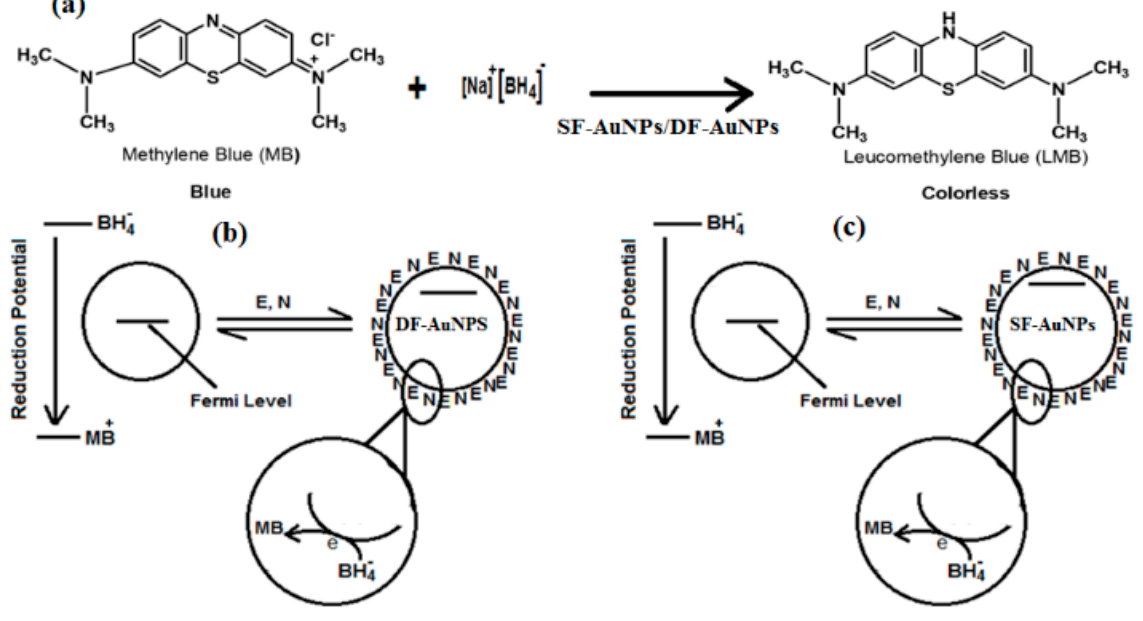
Figure 6. ( a ) reduction reaction of MB by SF-AuNPs/DF-AuNPs, and Schematic of catalytic process on ( b ) DF-AuNP, ( c ) SF-AuNP. E(electrophile, MB), N(nucleophile, BH − 4